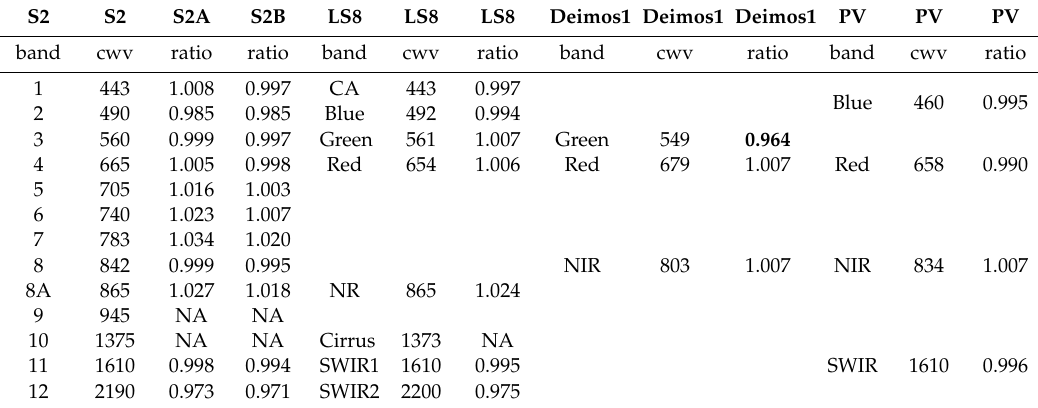
Table 3. Mean ratio (over all observations) of the satellite-measured TOA reflectances to the 6SV TOA reflectance reference simulations over Libya-4.